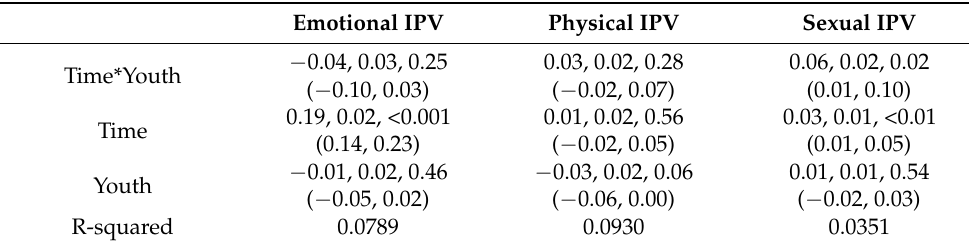
Table 3. Multiple Linear Regression on Differential Changes in Trends of Reporting IPV in the Past 12 Months based on Age Group among Ever-partnered Female Respondents who Completed the Domestic Violence Module ( β , SE, p -value (95% CI) b . Emotional IPV Physical IPV Sexual IPV